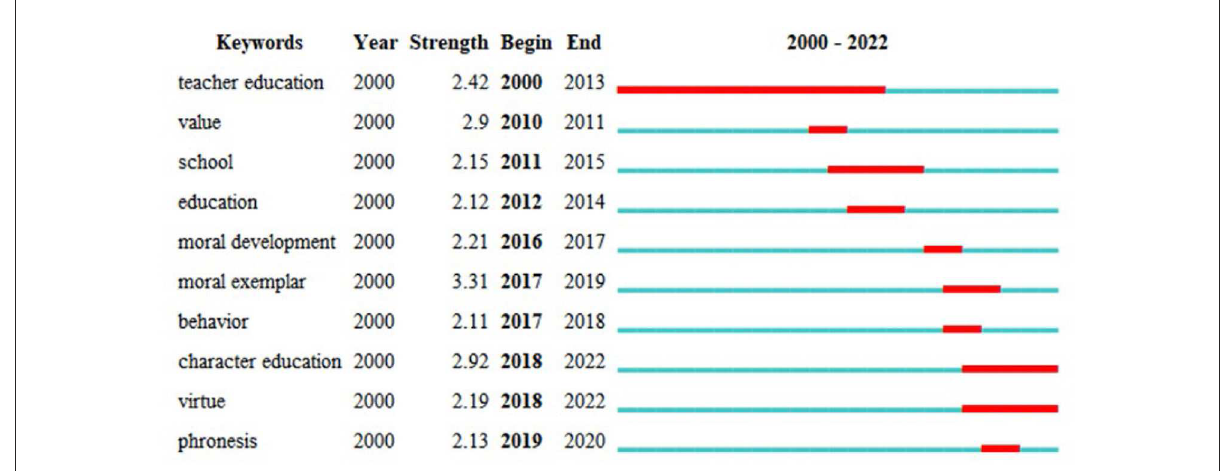
FIGURE5 Top 10 keywords with the strongest citation